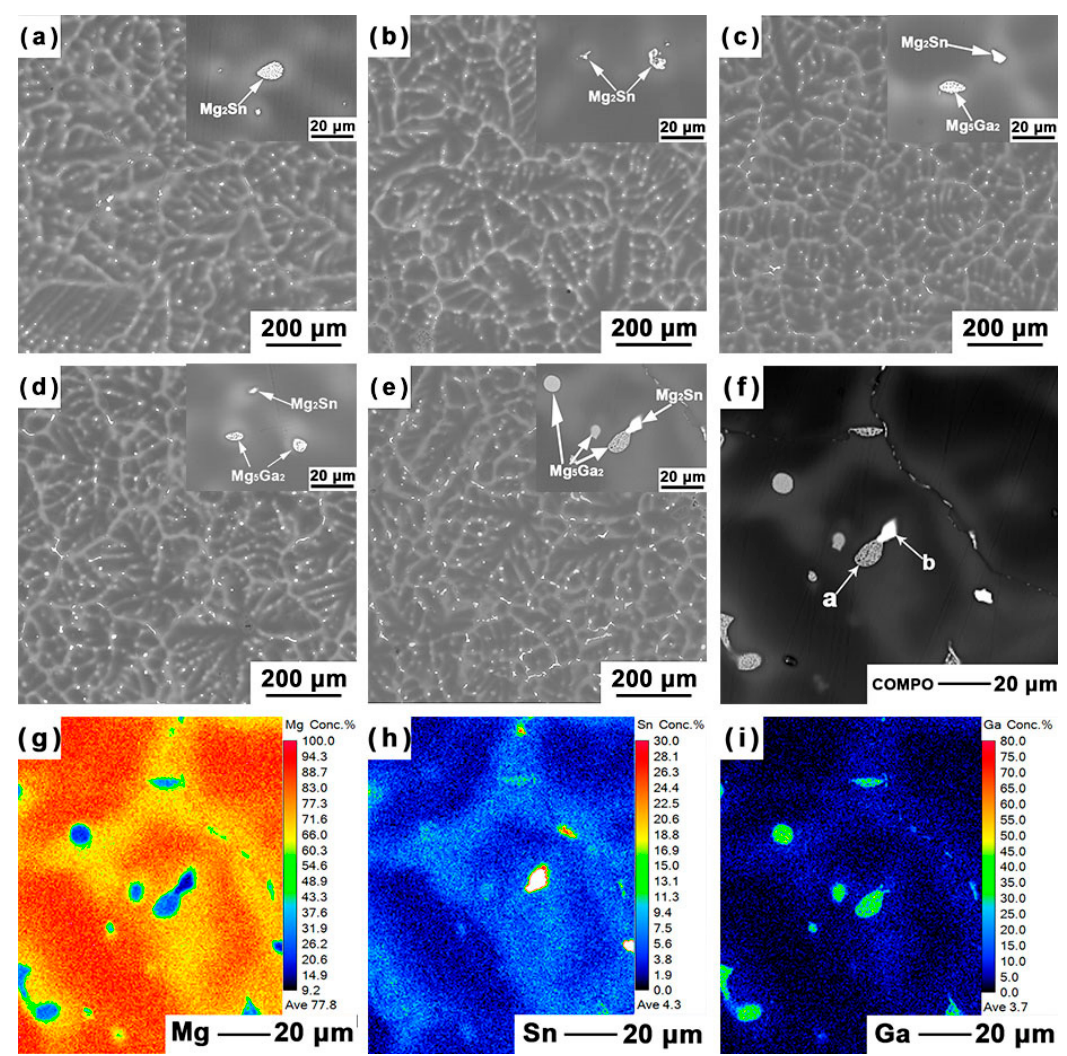
Figure 2. BSE micrographs of the Mg–5Sn– x Ga alloys: ( a ) Mg–5Sn, ( b ) Mg–5Sn–0.5Ga, ( c ) Mg–5Sn–1Ga, ( d ) Mg–5Sn–2Ga, ( e ) Mg–5Sn–3Ga. The inserts are zoom-in views showing the second phases. ( f – i )